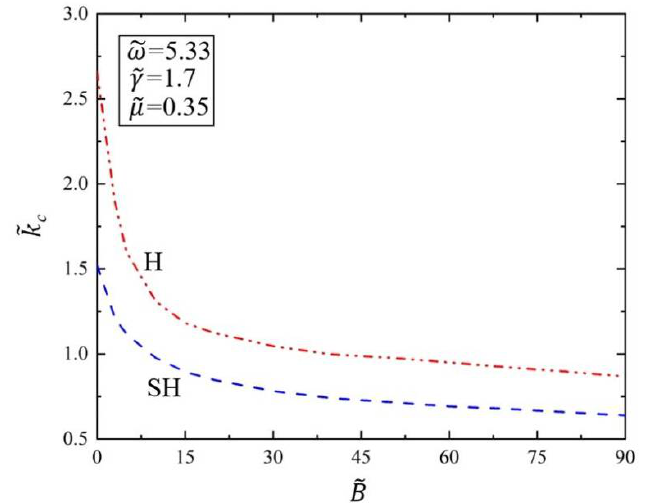
 Figure 8. Variation of the critical wave number (cid:101) k c of Faraday instability with the bending stiffness (cid:101) B . k of Faraday instability with the bending stiffness Figure 8. Variation of the critical wave number c The dimensionless parameters are set as (cid:101) ω = 5.33, (cid:101) γ = 1.7, and (cid:101) µ = 0.35. The critical wave number  B . The dimensionless parameters are set as  . The critical (cid:101) k c decreases with the increase in bending stiffness (cid:101) B   B . k decreases with the increase in bending stiffness wave number c